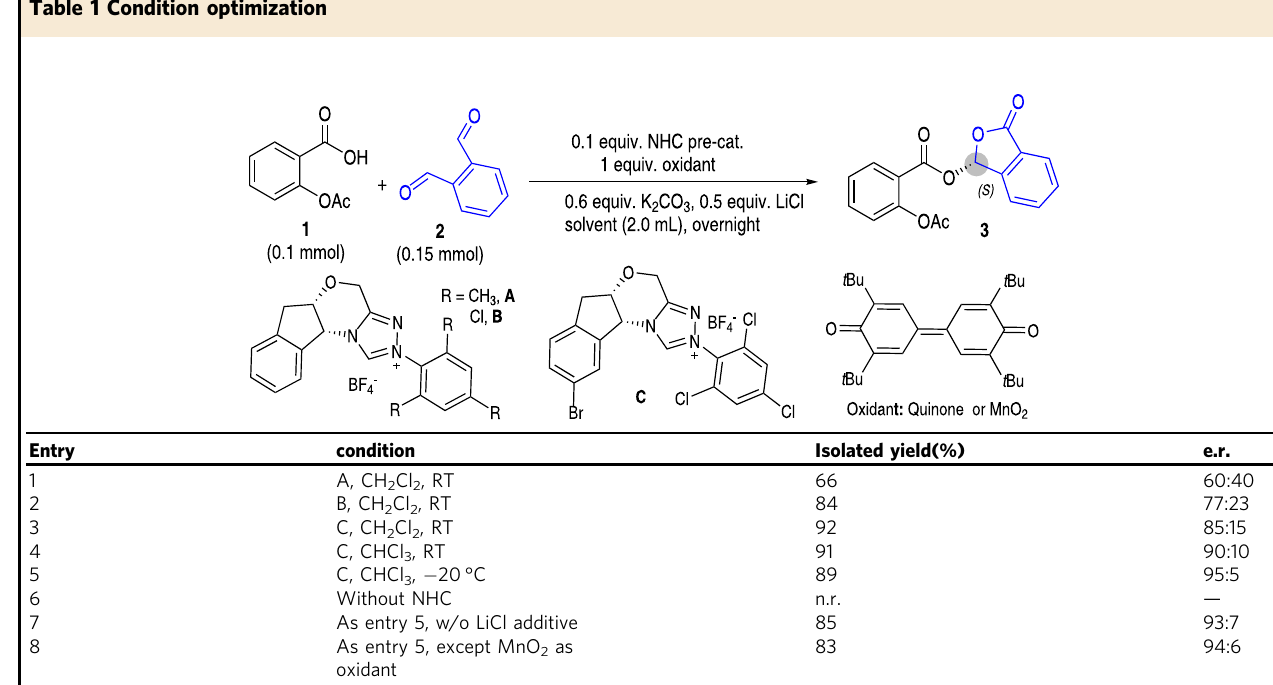
Table 1 Condition